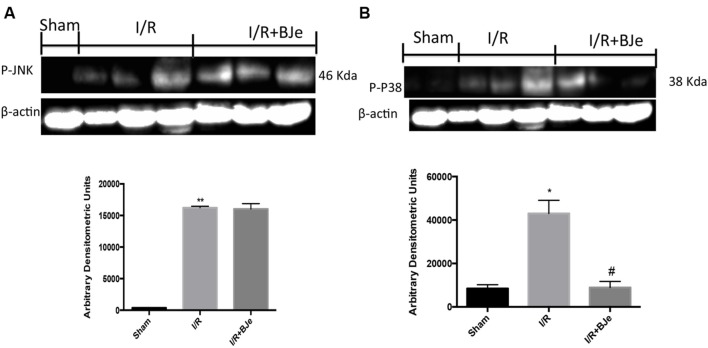
Effect of BJe on MAPKs pathway. Representative western blots showing the effects of BJe on p-JNK (A), and p-P38 expression after I/R injury. I/R caused an increase in p-JNK (A), and p-P38 (B) expression. BJe treatment was not able to reduce p-JNK (A) but significantly decreased p-P38 expression (B). A representative blot of lysates (A,B) obtained from 10 animals/group is shown, and densitometry analysis of all animals is reported. The results in (A,B) are expressed as means ± SEM of 10 mice for each group. ∗P < 0.05 vs. SHAM; ∗∗P < 0.01 vs. SHAM; #P < 0.05 vs. I/R.